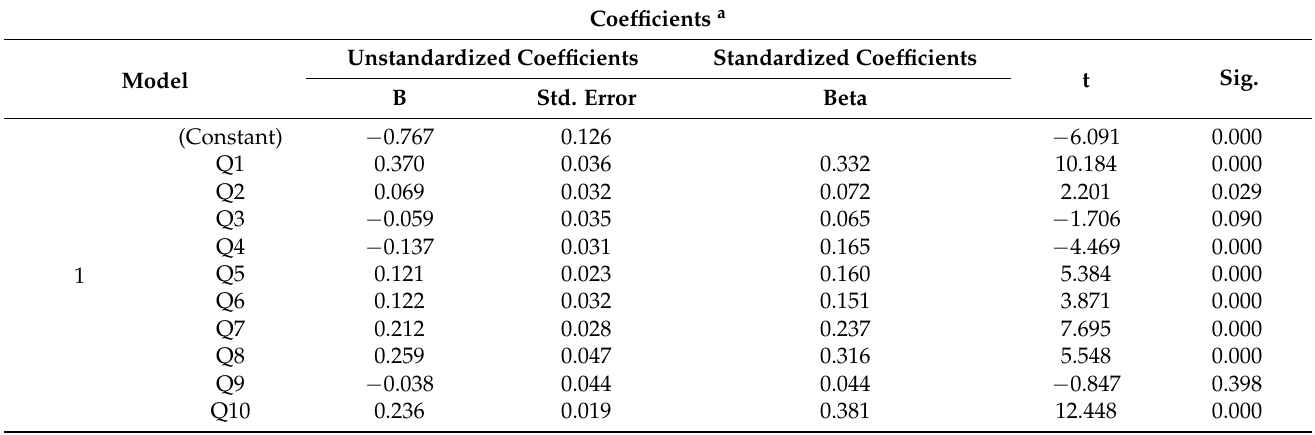
Table 3. Determining the crisp weights of the factors using the regression coefficients.